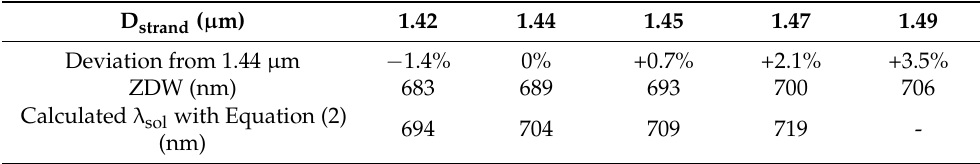
Figure A3. ( a ) Simulated GVD parameter β 2 and ( b ) calculated phase-mismatching rate of DW generation ∆ β DW in the second order PBG for different strand diameters ( γ = 6.5 W − 1 /km, pulse: 100 fs, 80 MHz) using Equation (2) of the manuscript. The wavelength of the DW (657 nm) and the P sol calculated from the DW generation threshold (0.08 nJ) are taken from the experiment (Figure 3b). The corresponding soliton wavelengths are obtained by the crossing of the individual curves with the zero line ( ∆ β = 0). Note that the green square in ( b ) indicates the measured soliton wavelength in the experiment. Table A1. ZDWs and soliton wavelengths calculated by Equation (2) of CS 2 -PBGF assuming different strand diameters (the percentage indicates the deviation from D strand = 1.44 μ m). The assumed diameters roughly correspond to the intrinsic range of strand diameter deviation of the PCF used that needs to be taken into account. Note that no soliton wavelength can be calculated for D strand = 1.49 µ m as the pump pulse (700 nm) locates in the normal dispersion region.